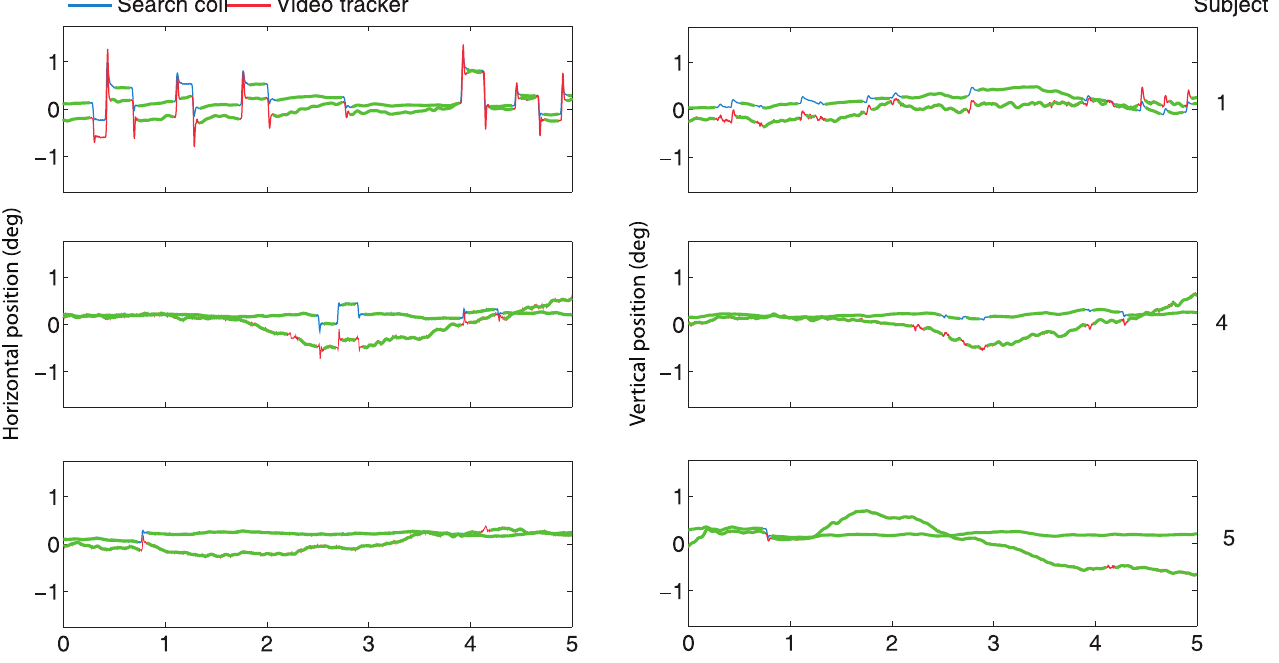
Fig 9. Examples of simultaneous horizontal drift traces (green lines) obtained with the search coil and video tracker, for each participant contributing to the drift analyses. For illustration purposes, a small offset of 0.2 deg has been added to the search coil data.